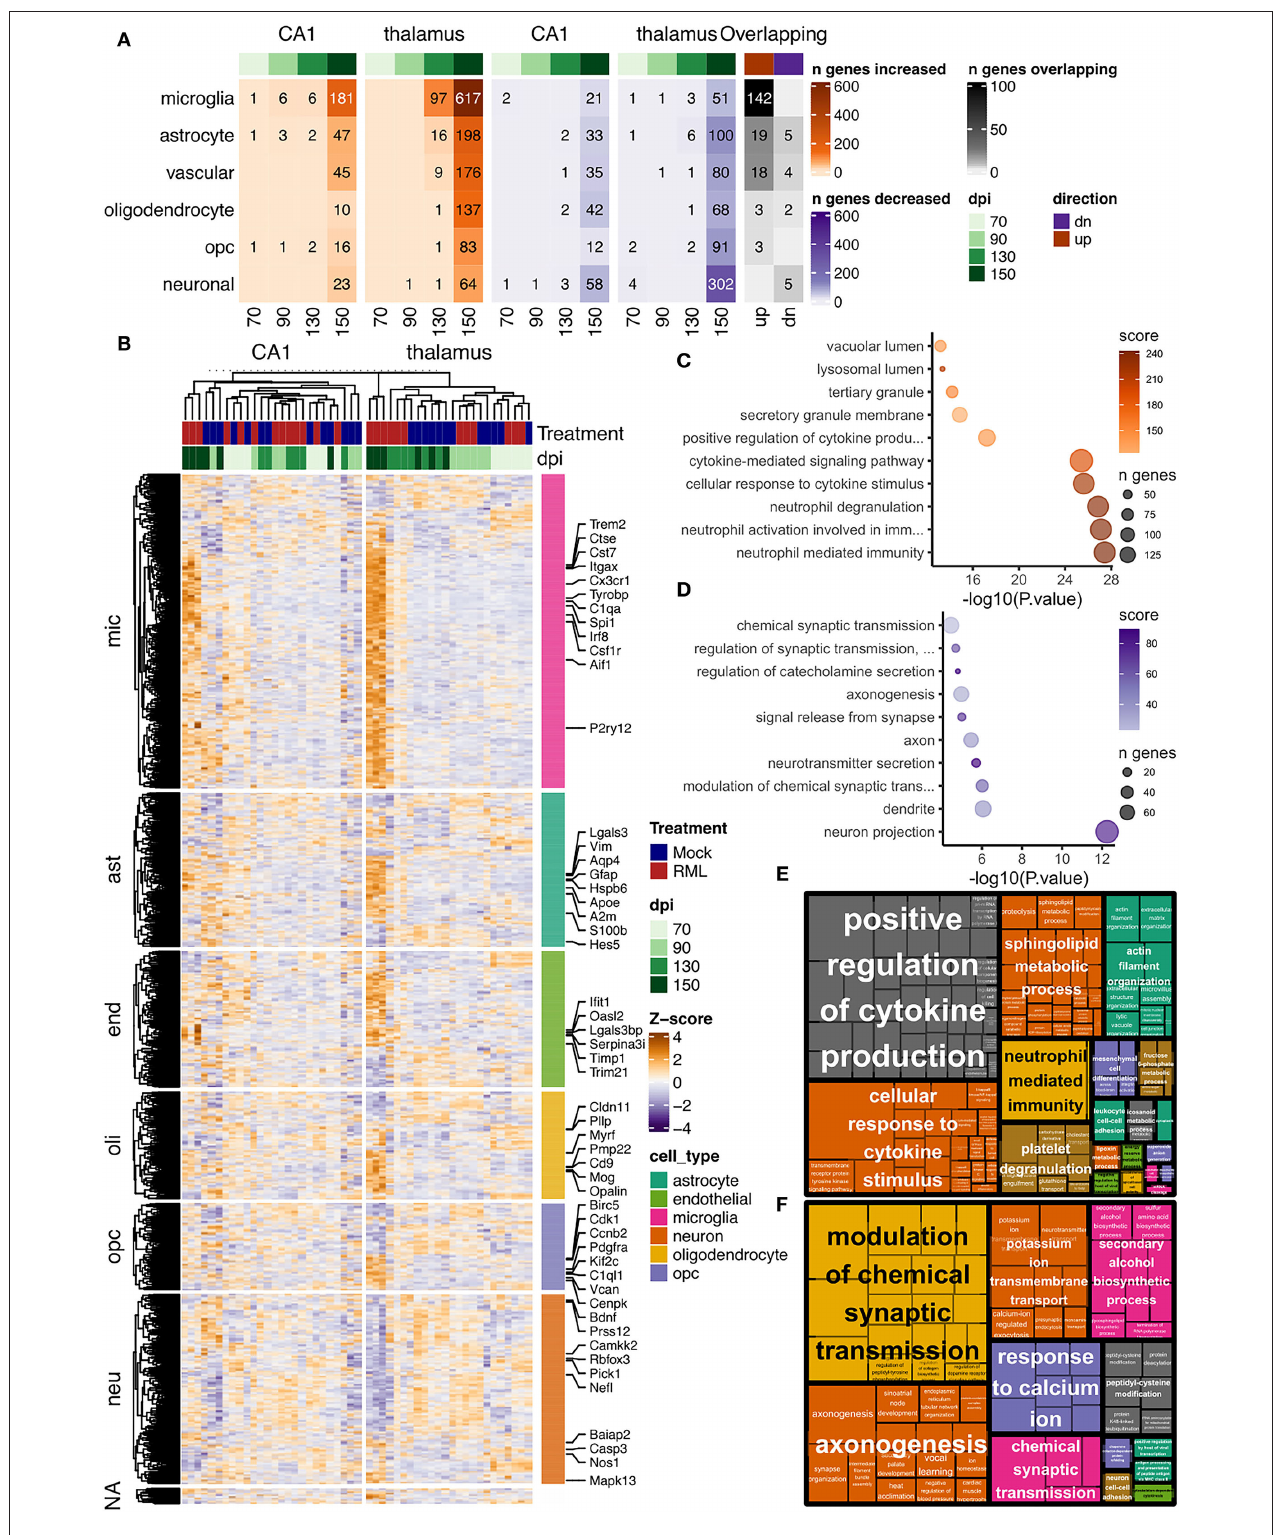
FIGURE 4 | Transcriptional profiles of prion infection in the CA1 and thalamus of RML infected mice. Prion altered transcripts were defined by baseMean read count > 15, log 2 fold change magnitude > 0.5 and FDR adjusted p < 0.05 in the CA1 at 150 dpi, and thalamus at 130 and 150 dpi. Transcripts were assigned to one of six